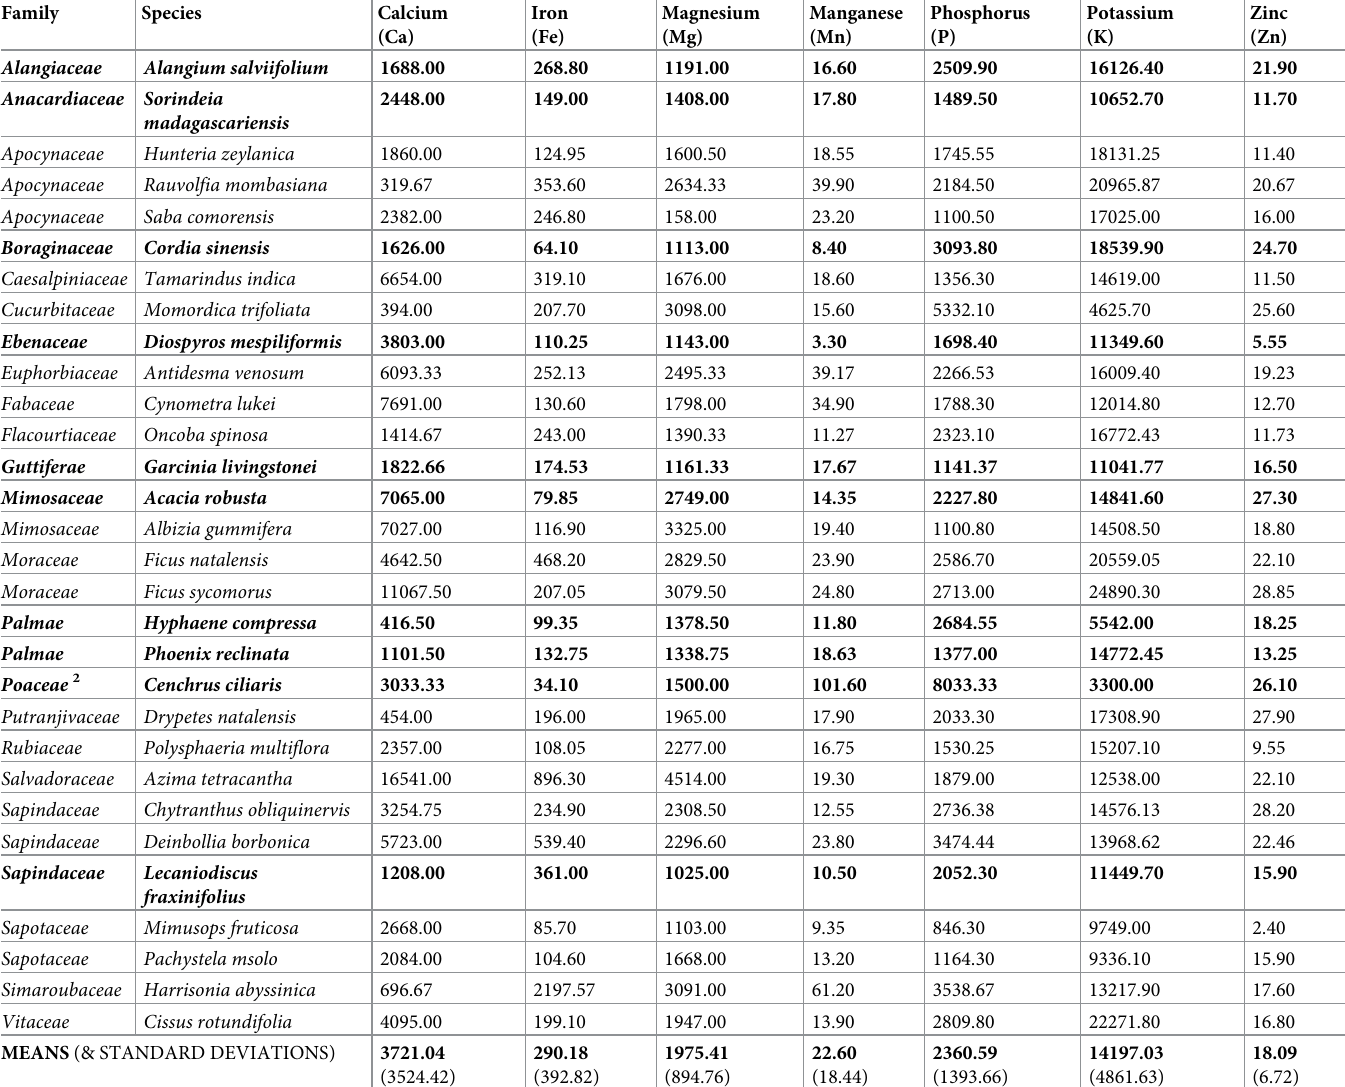
Table 3. Mchelelo baboon dietary mineral content (mg/kg [DM])—forest samples